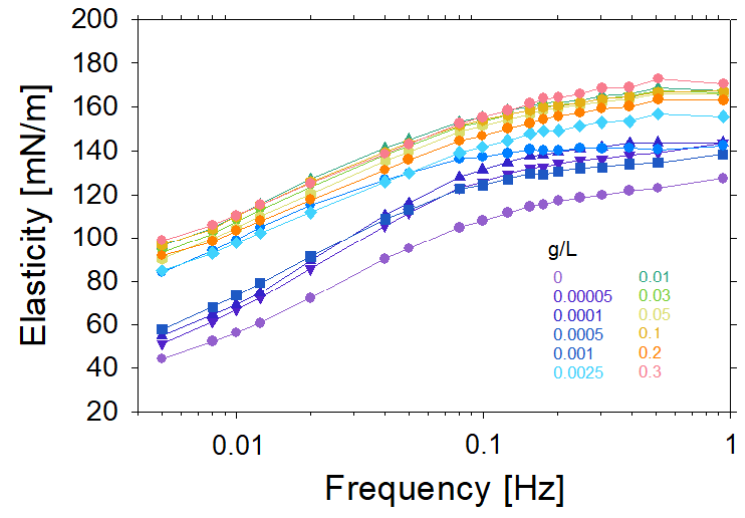
Figure 6. Dilational viscoelasticity versus frequency measured by the oscillating drop method in the presence of 0.1 wt% acetic acid and a solution pH of 3.4. The saponin concentration was fixed to 0.1 g/L, while the chitosan concentration was varied from 0.0005 to 0.3 g/L as indicated in the figure.